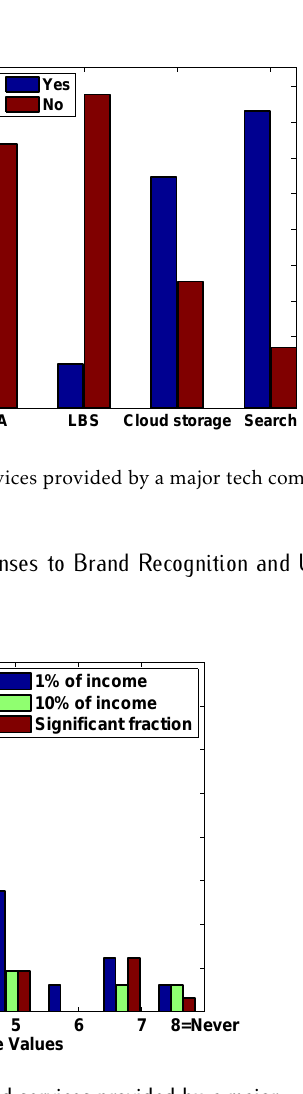
Figure 7. Usage of technologies and services provided by a major tech company despite being aware that users’ data is sensed (best viewed in